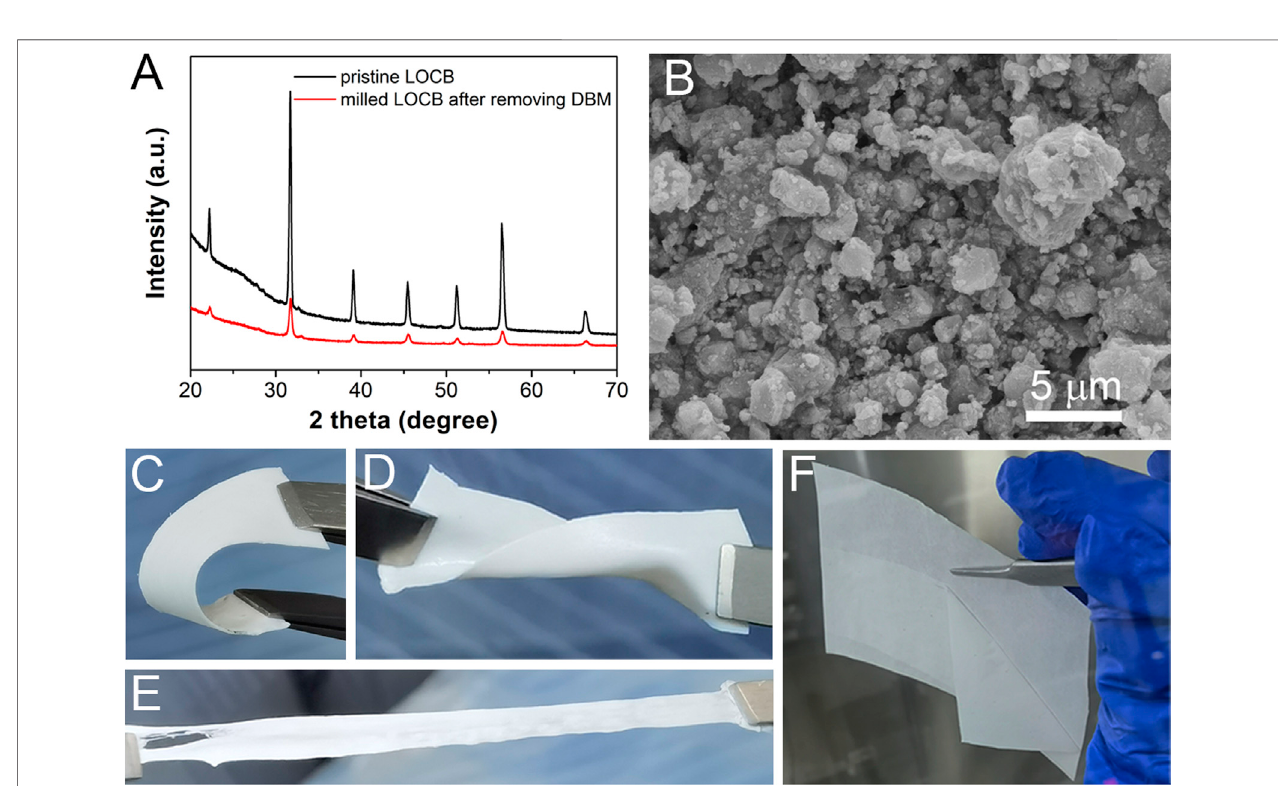
FIGURE 1 | (A) XRD patterns of LOCB, (B) SEM image of the milled LOCB powders. (C – E) Bending, distorting, and stretching of the LOCB/NBR CPE fi lms. (F) Detaching of the CPE fi lm from silicone paper.